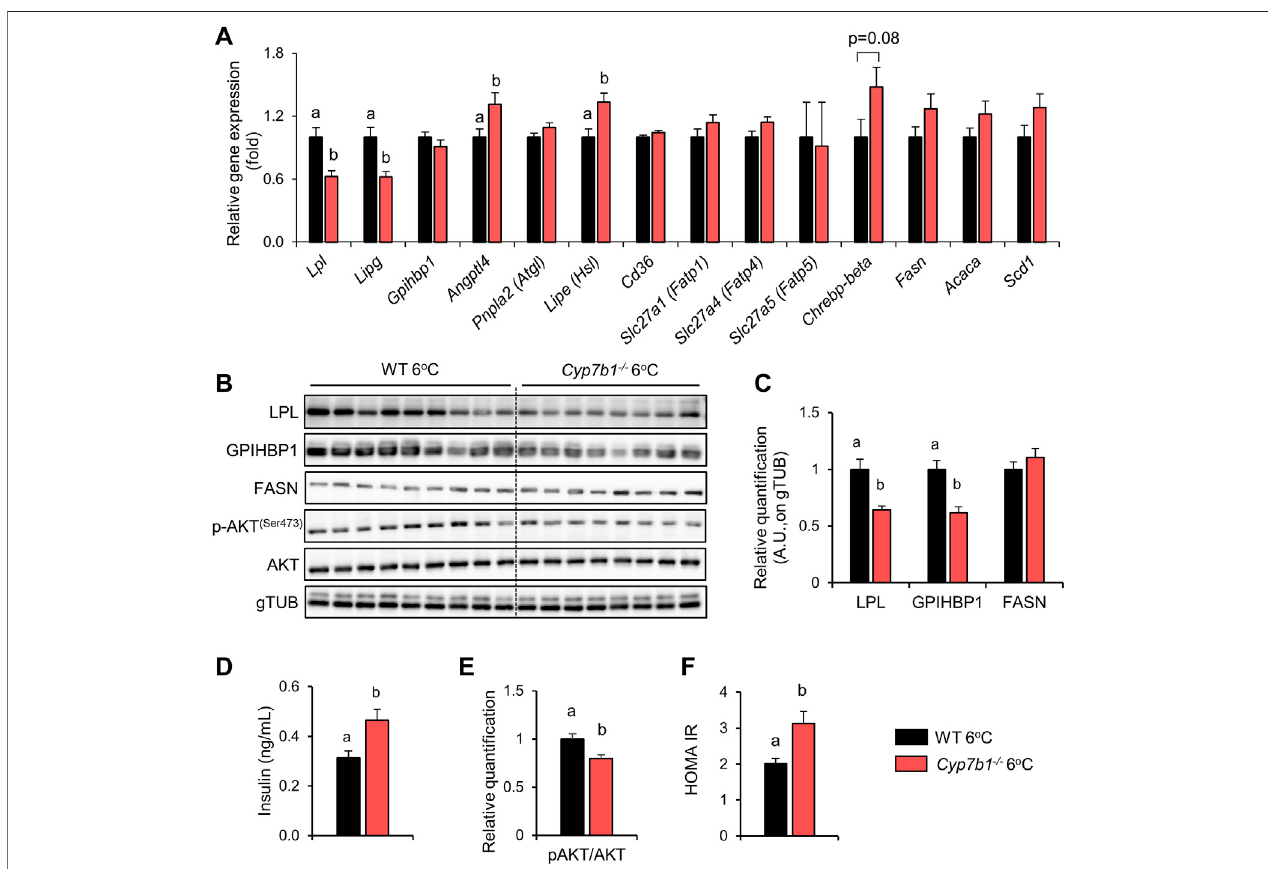
FIGURE5| Cyp7b1 deletionimpairsBATlipoproteinprocessingresponsesduringcoldexposure.WT(n=9)and Cyp7b1 − / − (n=8)littermateswerefedaWTDand housed for 1 week at a cold (6 ° C) environment. BAT relative gene expression of lipoprotein processing/uptake, glucose uptake, and de novo lipogenesis markers (A) , proteinlevelsofLPL,GPIHBP1,FASN,p-AKTandAKT (B) withrelativequanti fi cationofLPL,GPIHBP1,andFASN (C) .Plasmainsulinlevels (D) ,relativequanti fi cationof p-AKTandAKTblotsshowninB (E) ,andHOMA-IR (F) .Dataareshownasmeanvalues±SEM.Differentlettersindicatesigni fi cantdifferencesbetweengroups( p < 0.05) determined by two-way ANOVA.